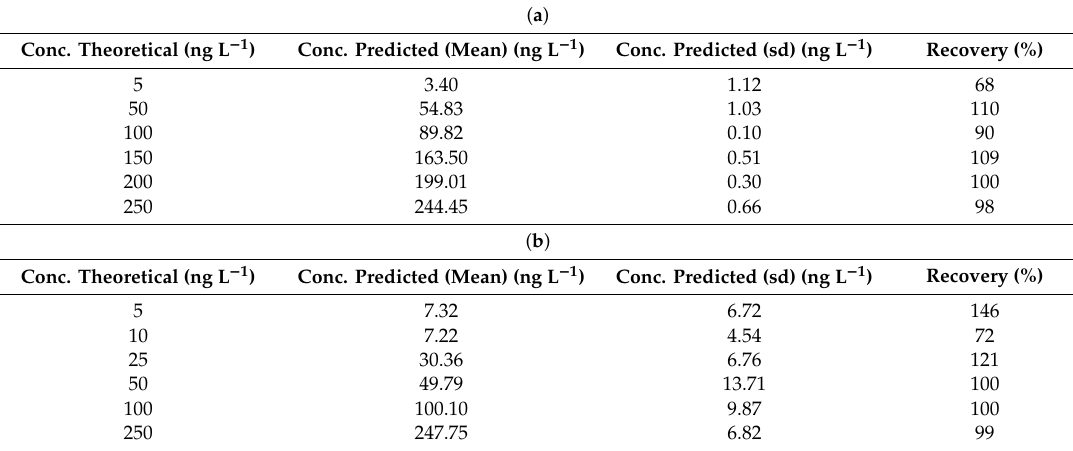
Table 2. ( a ) Predicted vs. theoretical concentrations and recovery for iprodione using the MIS sensor in white wine. ( b ) Predicted vs. theoretical concentrations and recovery for iprodione using the MIS sensor in red